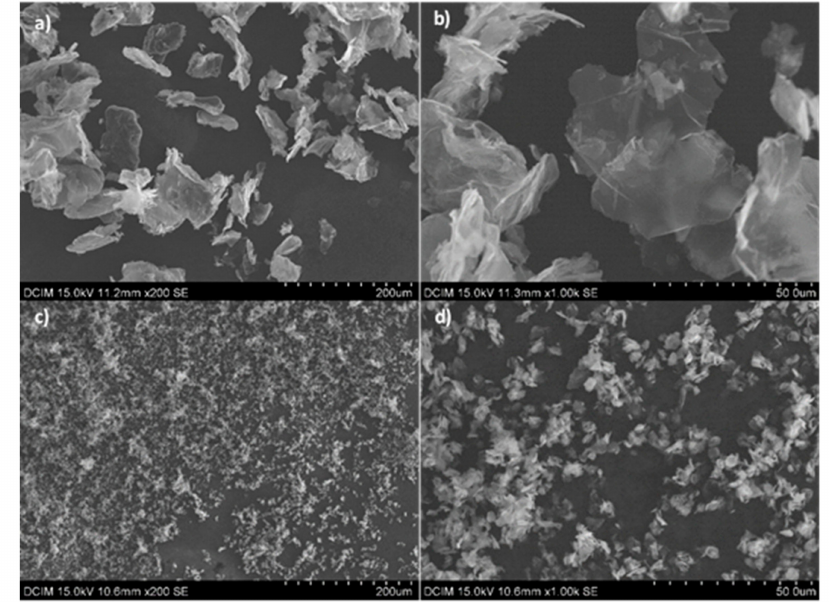
Figure 1. Scanning electron microscopy (SEM) micrographs of two types of graphene nanoplatelets: nonfunctionalised ( a , b ) and functionalised ( c , d